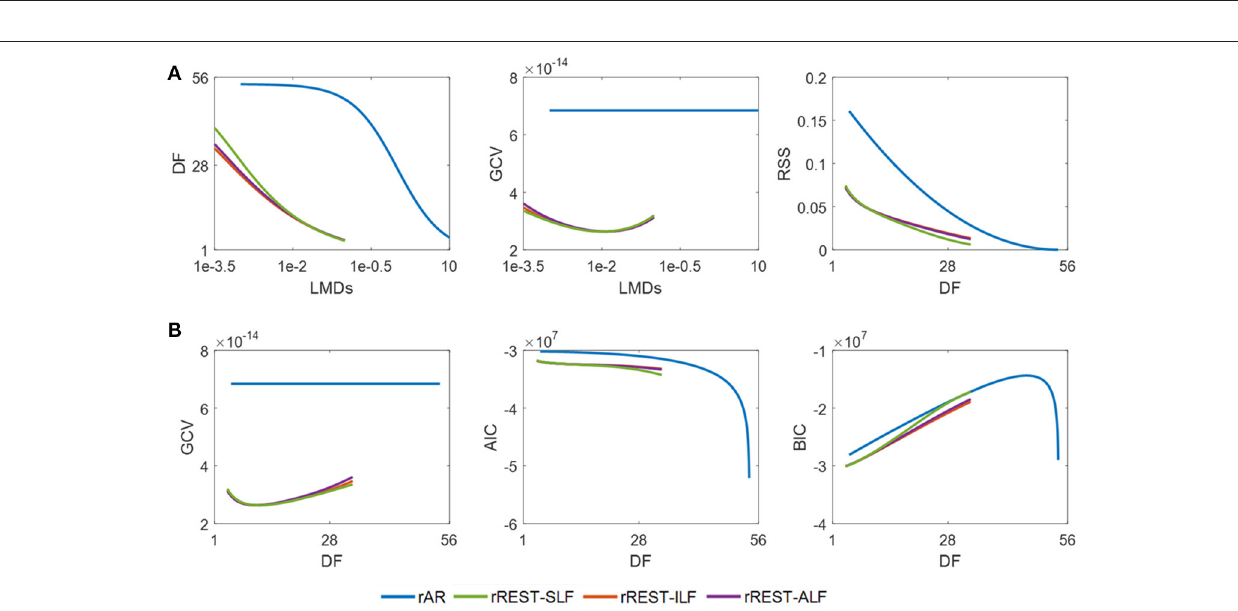
FIGURE 7 | The illustration of a real EEG data sample. (A) The electrodes position, (B) the waveform of one epoch.